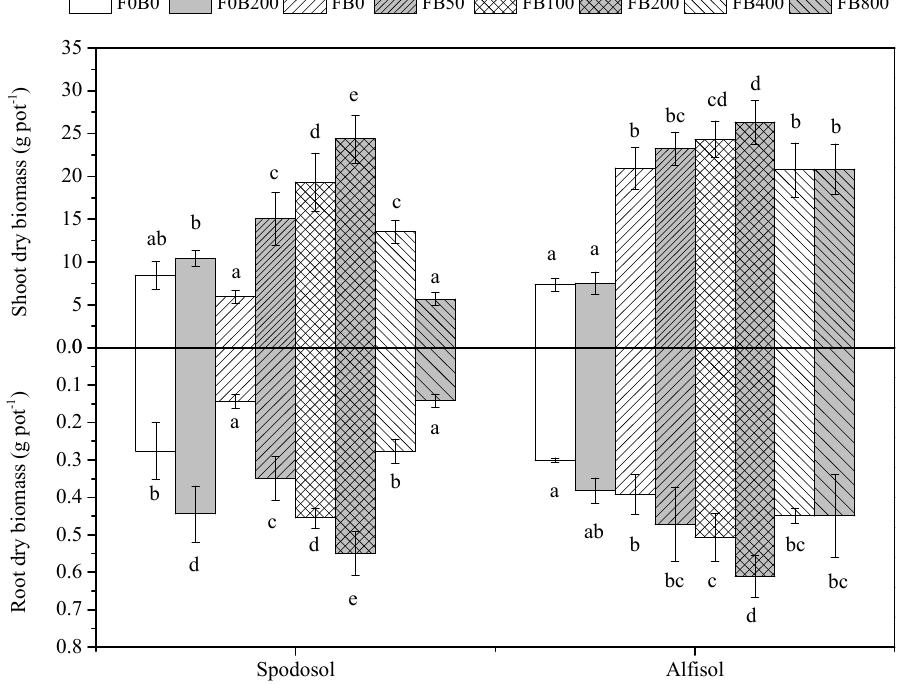
Figure 2. The shoot and root dry biomass of corn plants affected by different application rates of CNPs in Spodosol and Alfisol soils. F0B0, control (without fertilizers and CNPs); F0B200, without fertilizers and with CNPs at 200 mg kg − 1 soil; and FB0, FB50, FB100, FB200, FB400 and FB800 represent those with fertilizers and CNPs at application rates of 0, 50, 100, 200, 400 and 800 mg kg − 1 soil, respectively. Error bars represent the standard error of the mean ( n = 5). The letters a, b, c, d and e indicate statistically significant difference at p < 0.05 within each group comparison between the treatments. Bars with no common letters are significantly different ( p < 0.05).